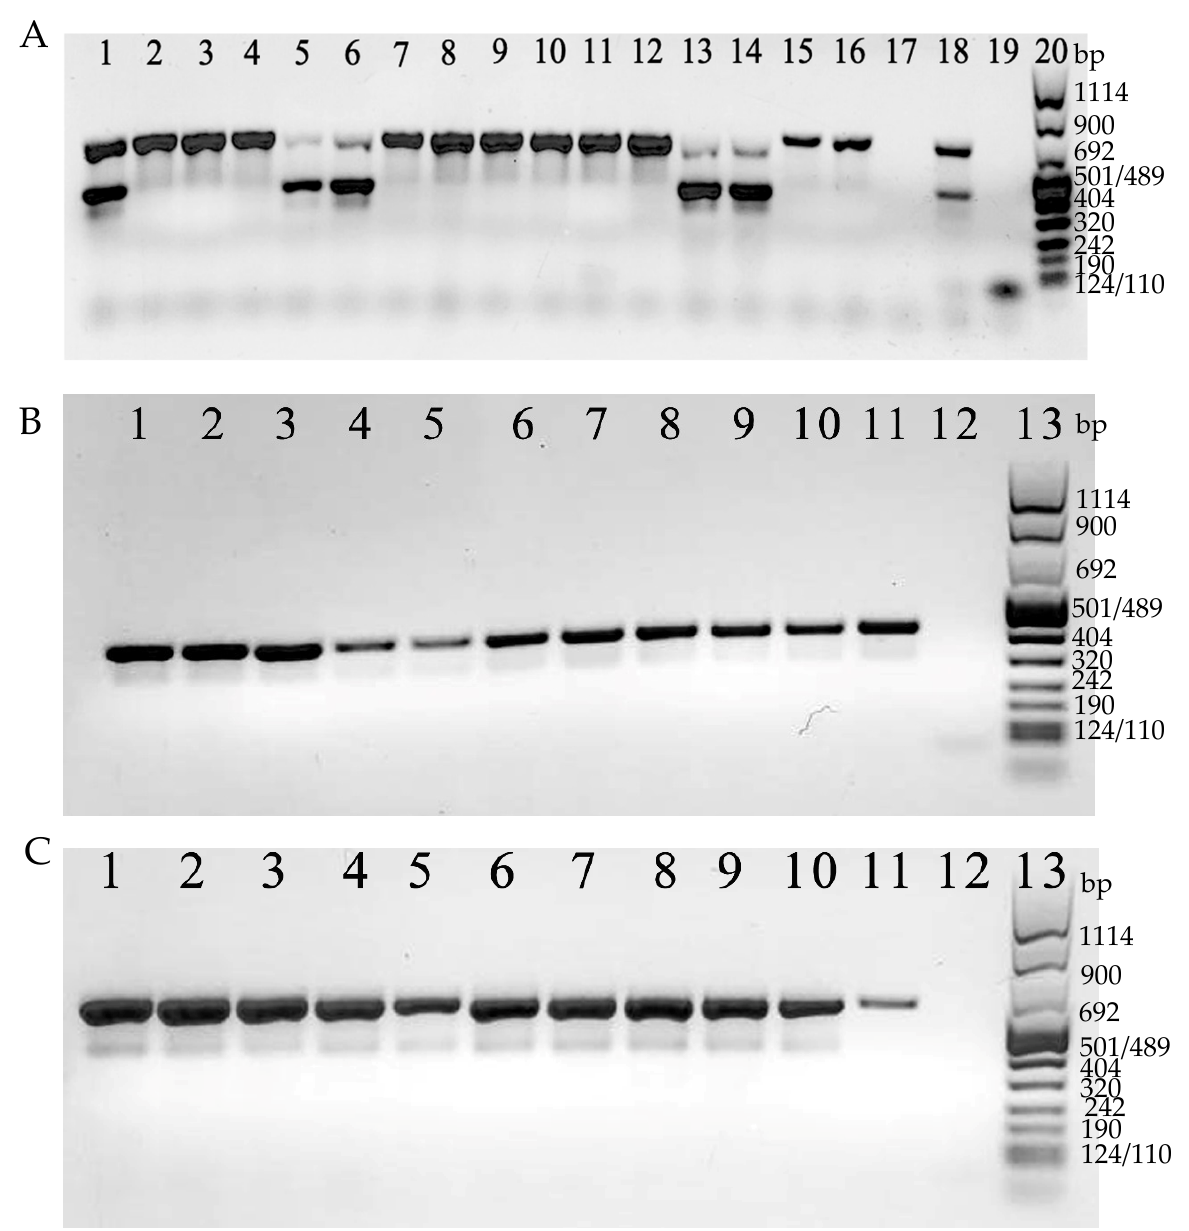
Figure 4. ( A ). Examples of detection of tcd A (624 bp) and tcd B (421 bp). Lines 1–16: C. difficile strains tested; line 17: C. difficile tcd A and tcd B negative control; line 18: C. difficile tcd A and tcd B positive control; line 19: negative PCR control (no DNA); line 20: 100 bp DNA Molecular Weight